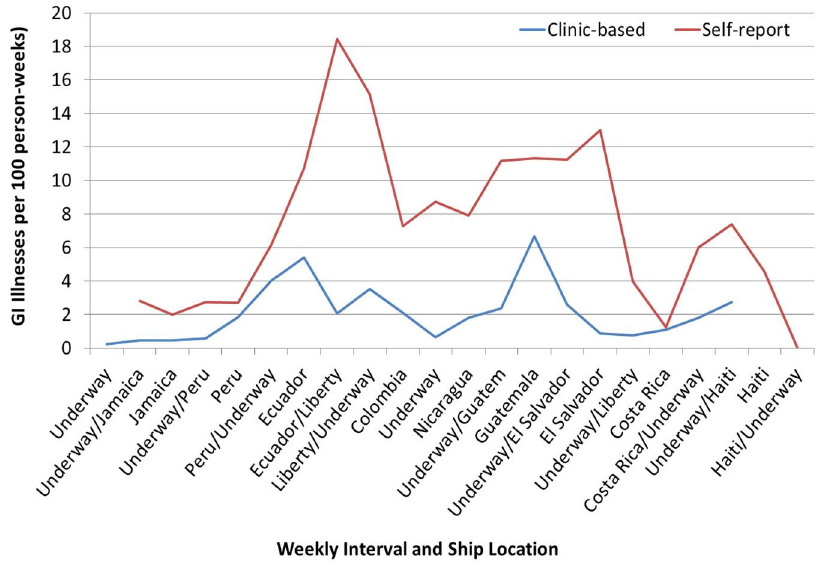
Fig 1. Epidemiologic Curve of Travelers ’ Diarrhea Incidence by Week from Self-Reported Questionnaire (Active Surveillance) and Clinic Visits (Passive Surveillance).